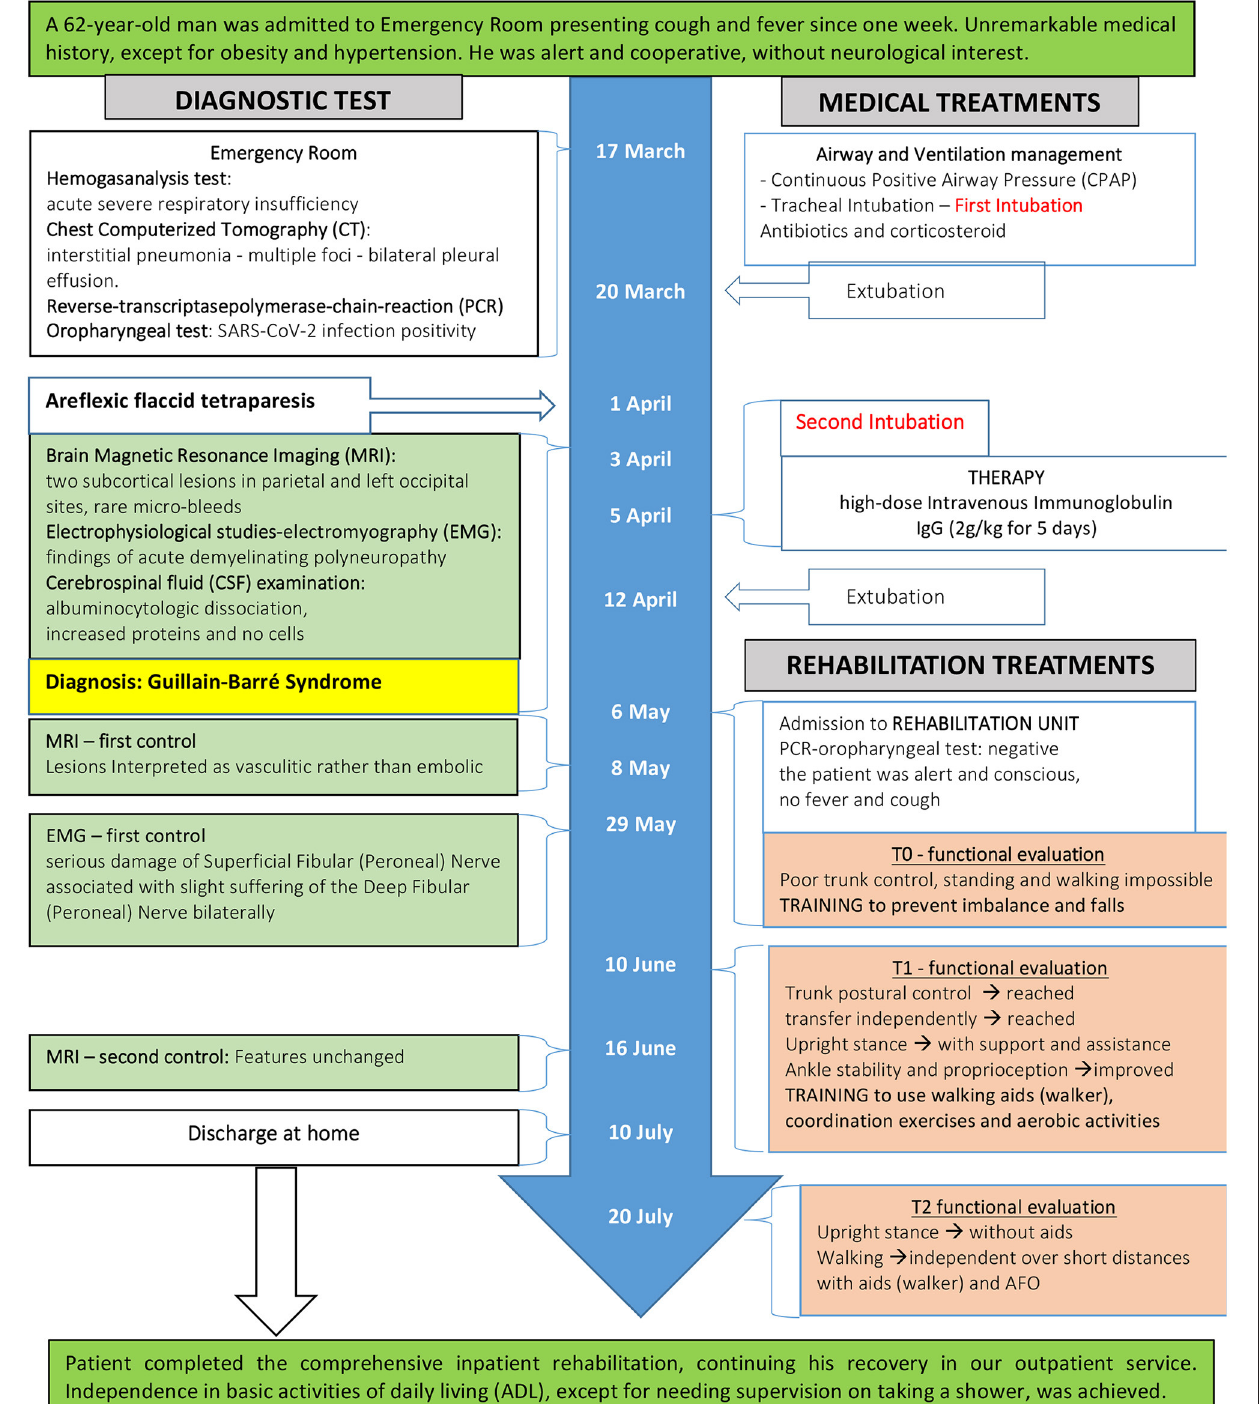
FIGURE 1 | Timeline of symptoms, diagnostic, interventions, and outcomes.